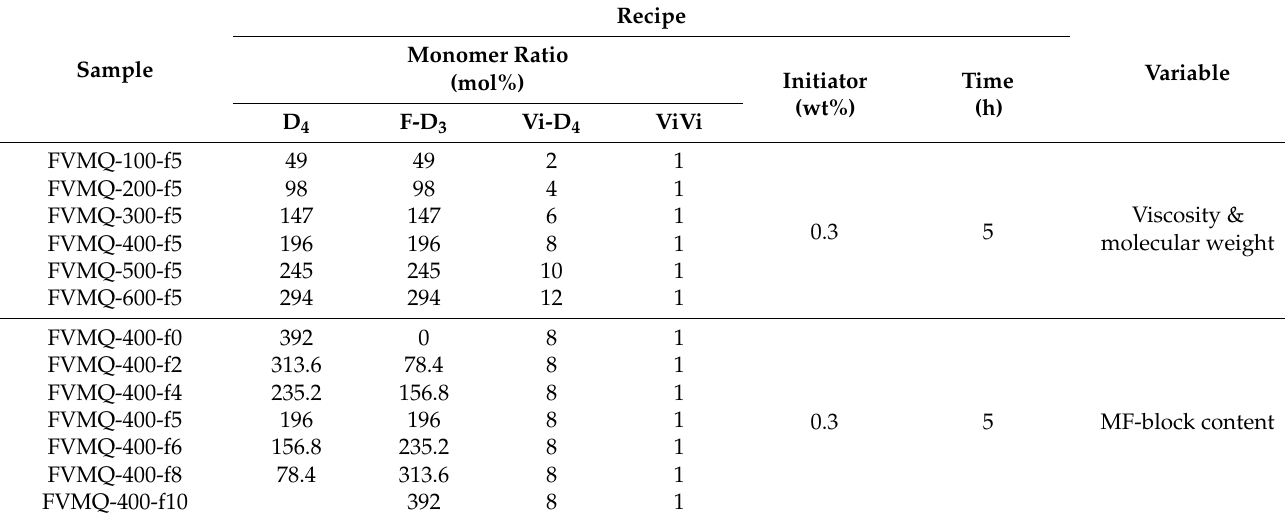
Table 1. Compositions of reactants for the preparation of FVMQs.